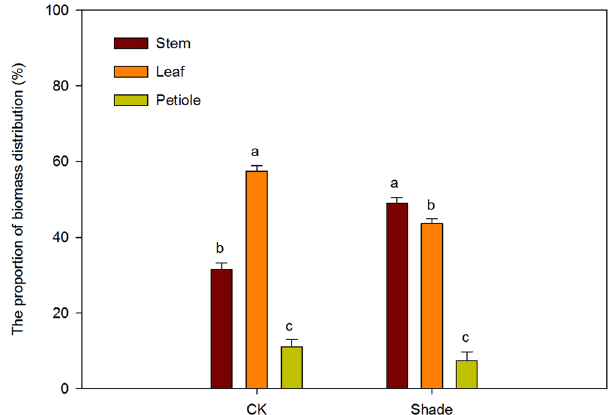
Figure 1. The proportion of biomass distribution of soybean planted in shade and full sunlight (CK). Values are means ± SD (n = 4). Statistical significance assessed by Duncan’s t-test. Lowercase letters indicates significant at 0.05 probability